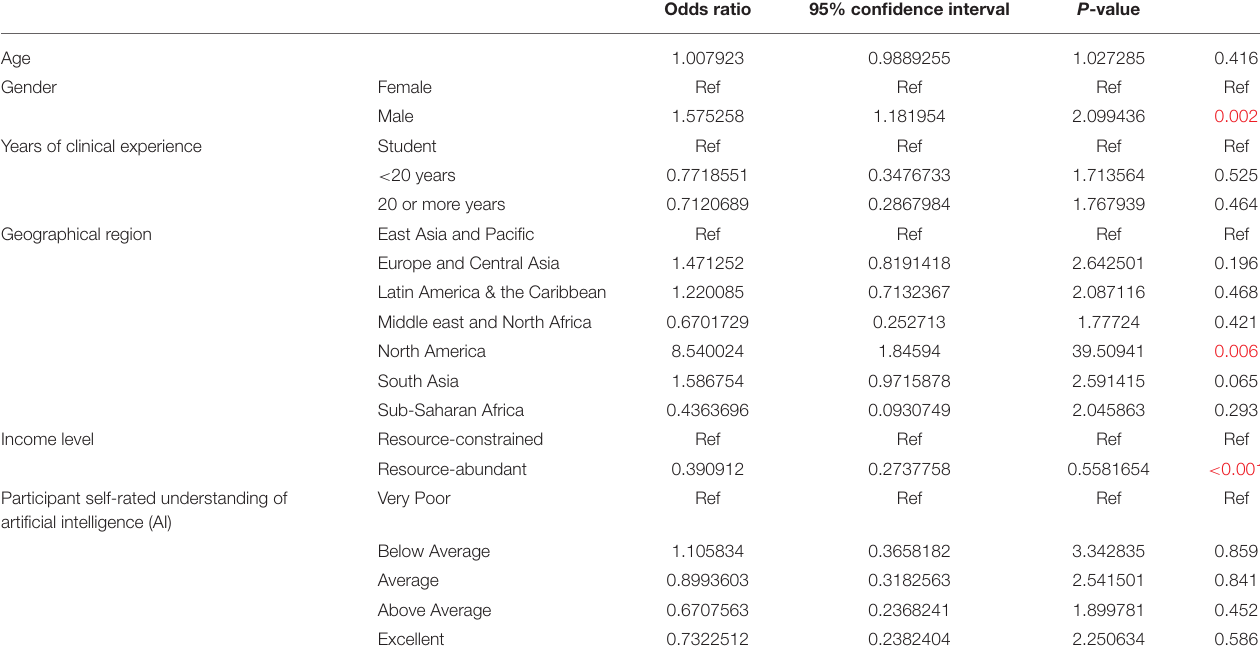
TABLE 3A | Organizational willingness to adopt AI for general eye